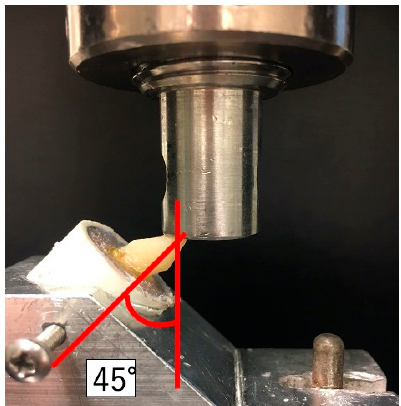
Figure 2. The photograph of the loading test set-up.